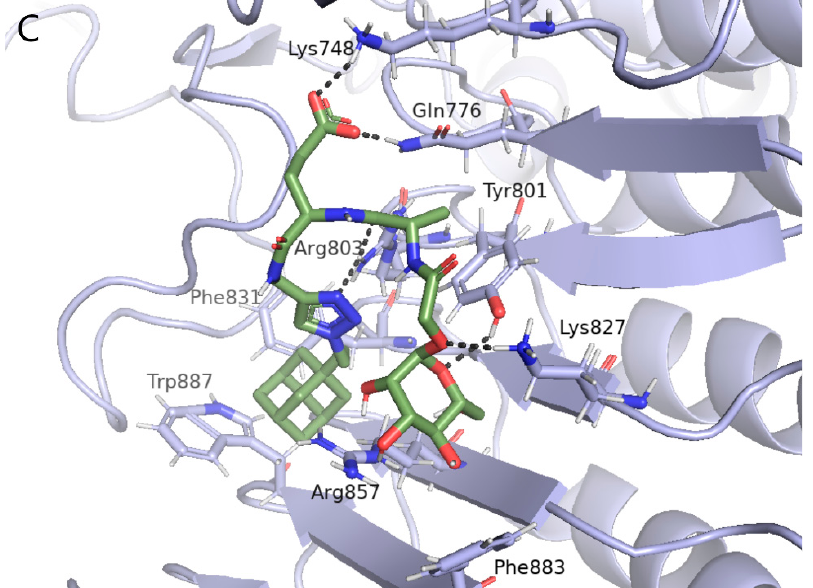
Figure 4. Molecular docking of ManDMPTAd ( A ), 6b ( B ) and 6c ( C ) in the proposed binding pocket on the concave surface of the LRR domain of NOD2. The stick model of different colors shows selected ligands, and the key amino acid residues of the NOD2 receptor around compounds have been displayed in the light blue stick model. Hydrogen bonds are shown as dark gray dashed lines.